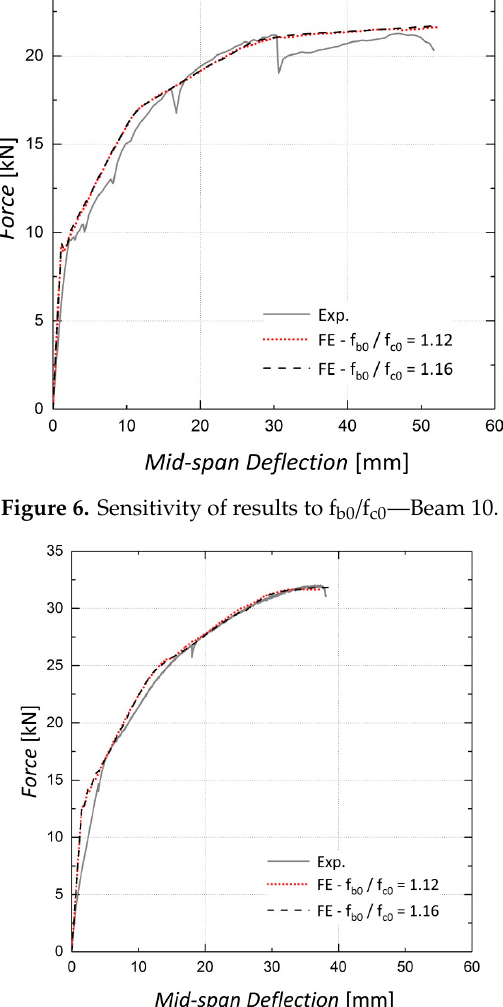
Figure 7. Sensitivity of results to f b0 / f c0 —Beam 11.